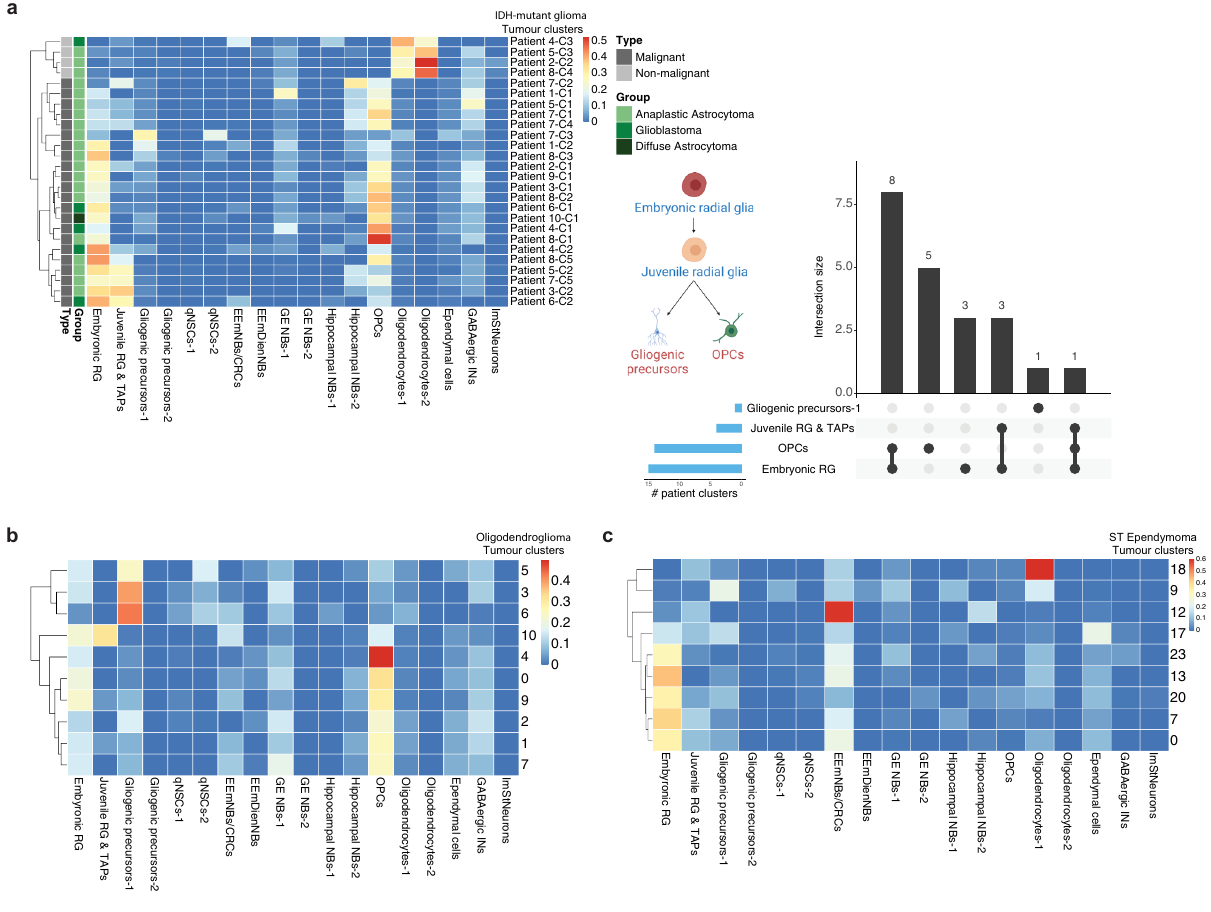
Fig. 5 Cerebral gliomas show developmental identities that re fl ect a foetal-like nature. a Left: deconvolution analysis heatmap of tumour clusters from 10 IDG patients from Venteicher et al., 2017 showing relative fractions of mouse cell-types for each patient cluster. Bars on the left indicate the state of the cells (malignant or non-malignant) and the type of glioma. Each patient sample was clustered separately (see patient clustering in Supplementary Fig. 7) and the clusters are denoted as e.g., “ Patient#1-cluster#1 ” = “ Patient 1-C1 ” (see Supplementary Data 1). Shown on the right is a bar plot summarizing the matching results and overlap size between the patient clusters and a schematic summary of the tumour lineage from the deconvolution analysis. b Deconvolution analysis heatmap of tumour clusters from 6 ODG patients from Tirosh et al. 2016 showing relative fraction of the mouse cell-types for each tumour cluster. The patient samples were analysed and clustered together (see Methods and clustering analysis in Supplementary Fig. 9b). c Deconvolution analysis of scRNA-seq tumour clusters obtained from four paediatric supratentorial ependymomas showing relative fraction of the mouse cell-types for each tumour cluster. The patient samples were clustered together and immune cells were identi fi ed and excluded using the expression of known immune markers (see Methods and clustering analysis in Supplementary Fig. 7d, e). Abbreviations as in in Fig.